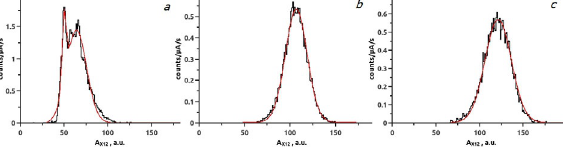
Fig. 9. Energy loss spectra in first gas gap. The maximum neutron energy E n max was: (a) 3 MeV; (b) 5 MeV; (c) 7 MeV.